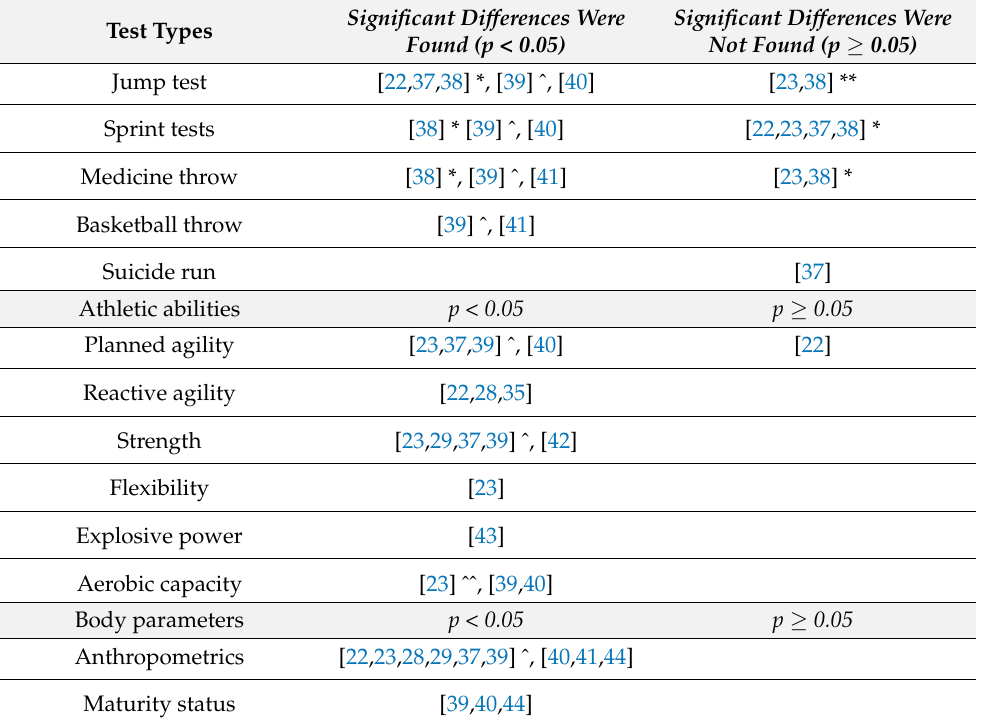
Table 2. Differences in test results, athletic abilities, and body parameters between players in different playing